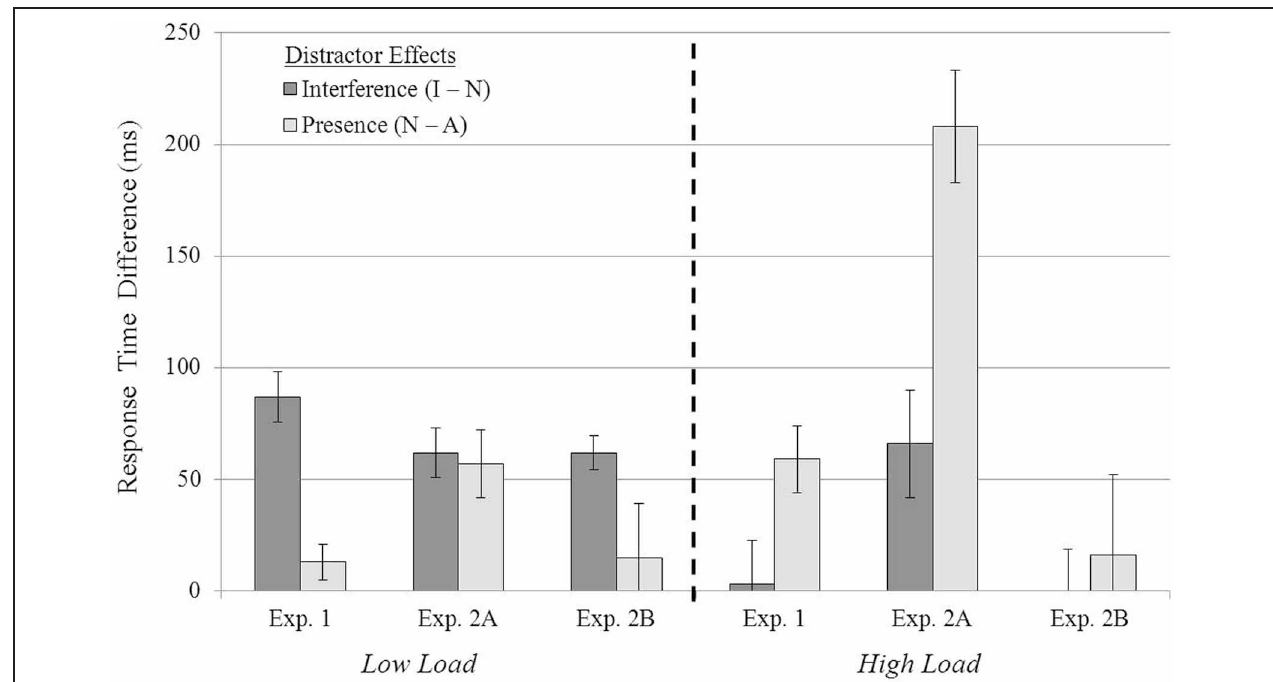
FIGURE 5 | Mean distractor interference (Incompatible − Neutral) and distractor presence (Neutral − Absent) effects shown as a function of perceptual load across experiments. Error bars reflect the standard error of the mean.